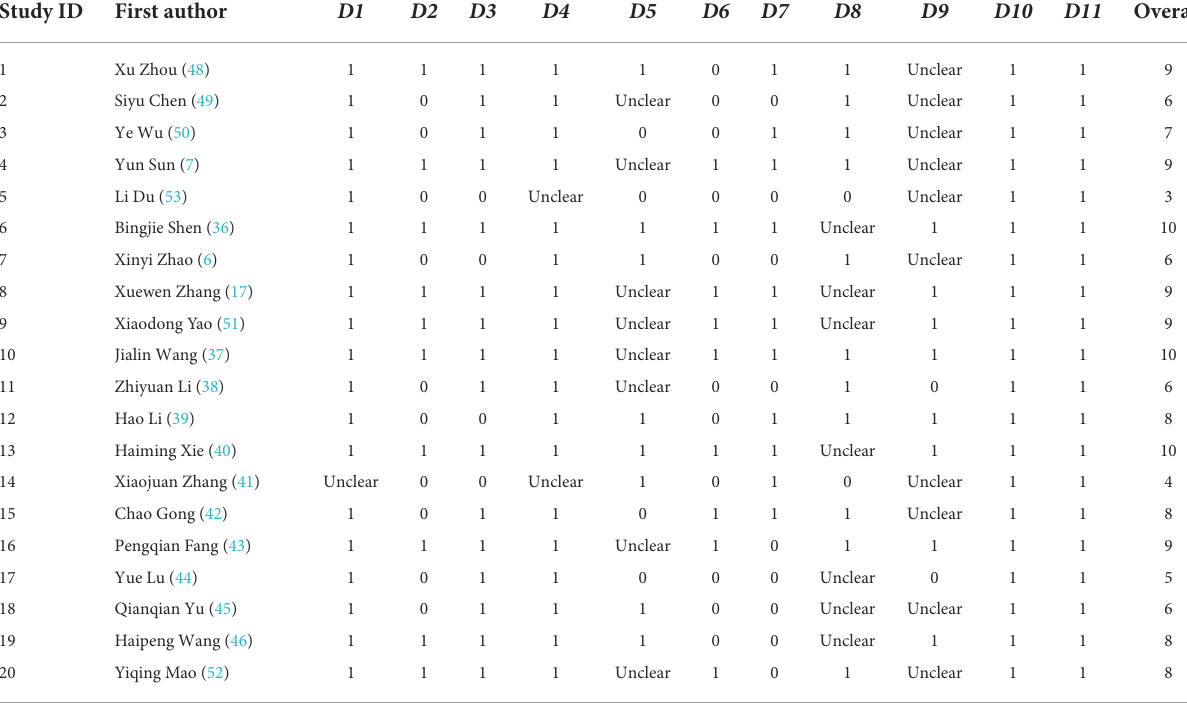
TABLE 4 Quality evaluation results of job burnout and turnover intention among Chinese